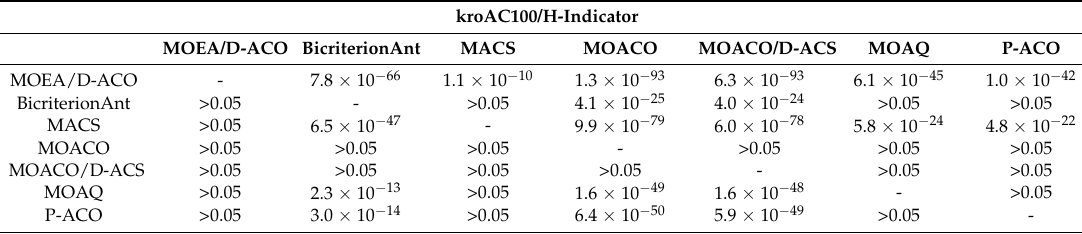
Table 4. Kruskal–Wallis test on kroAC100 based on H-indicator.